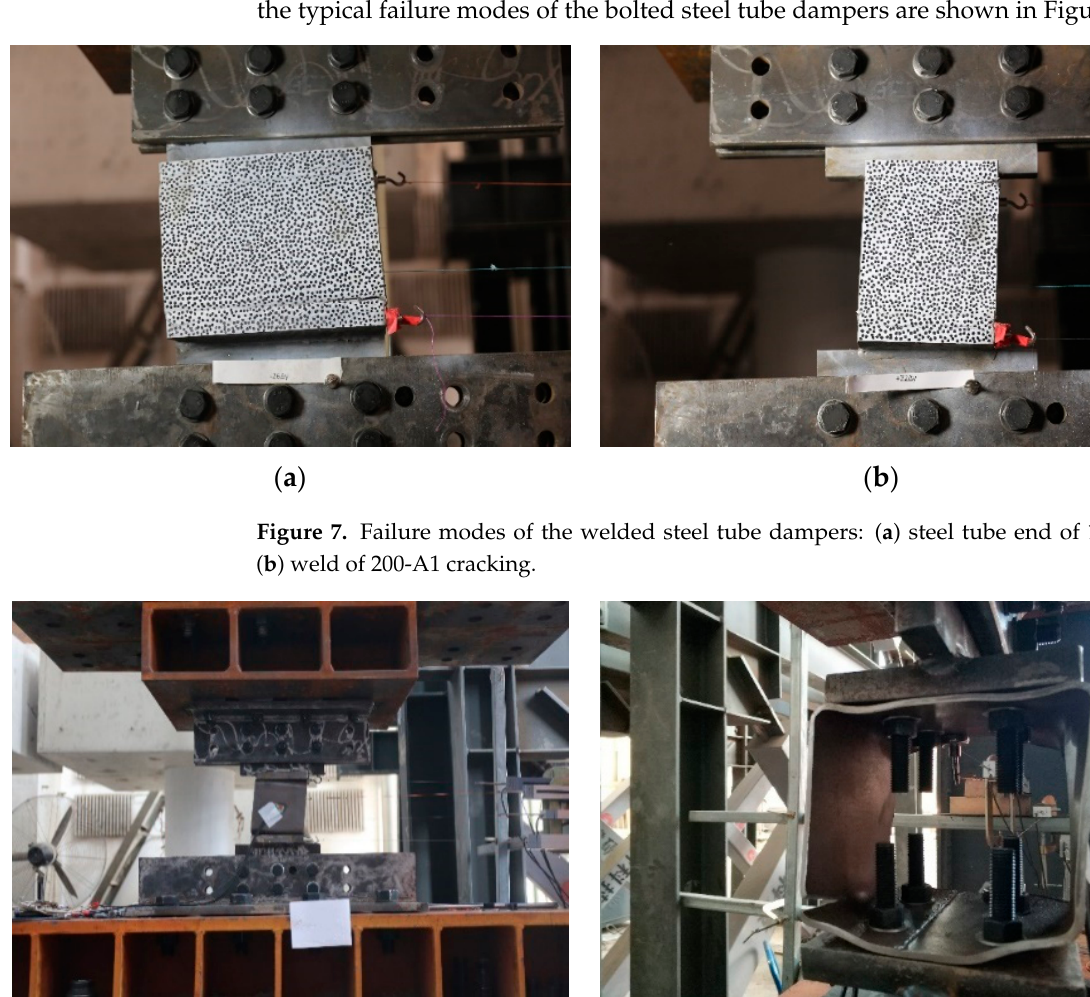
Figure 7. Failure modes of the welded steel tube dampers: ( a ) steel tube end of 150 ‐ C3 tearing; ( b ) weld of 200 ‐ A1 cracking.